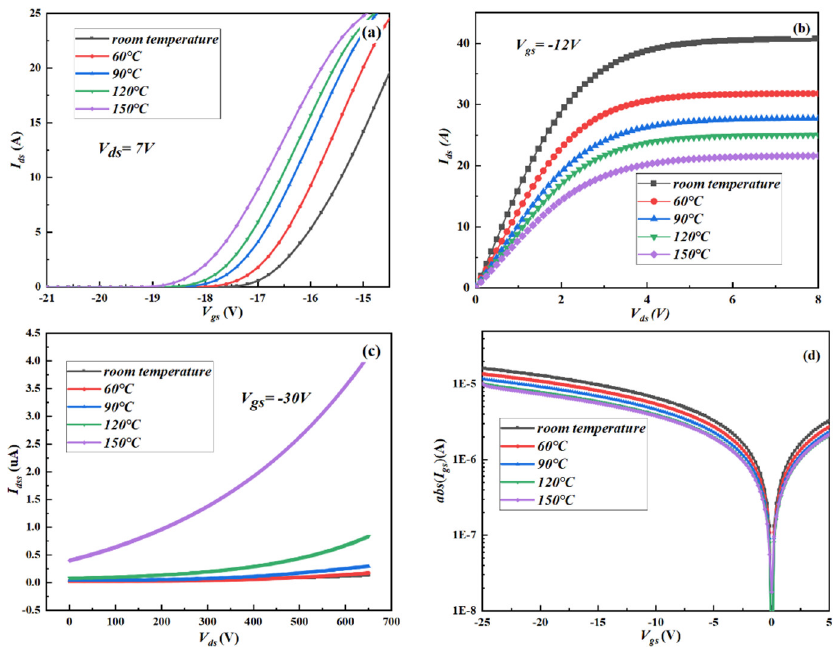
Figure 5. The influence of the temperature on the electrical properties of the double−layer GaN MISHEMTs. ( a ) Transfer characteristics, ( b ) output characteristics, ( c ) drain−to−source leakage current, ( d ) gate−to−source leakage current. Data was measured by the semiconductor device analyzer (Agilent B1500 and B1505 are produced by Keysight, Santa Rosa, CA, USA).